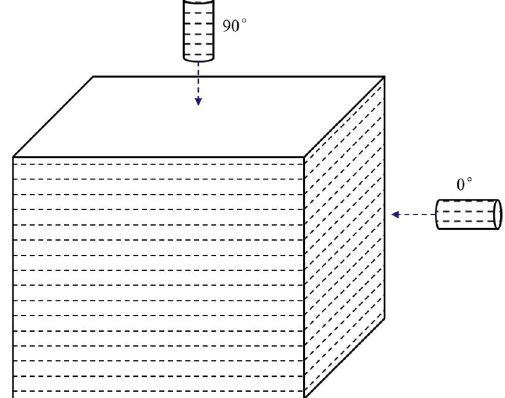
Figure 2. Schematic diagram of shale coring.